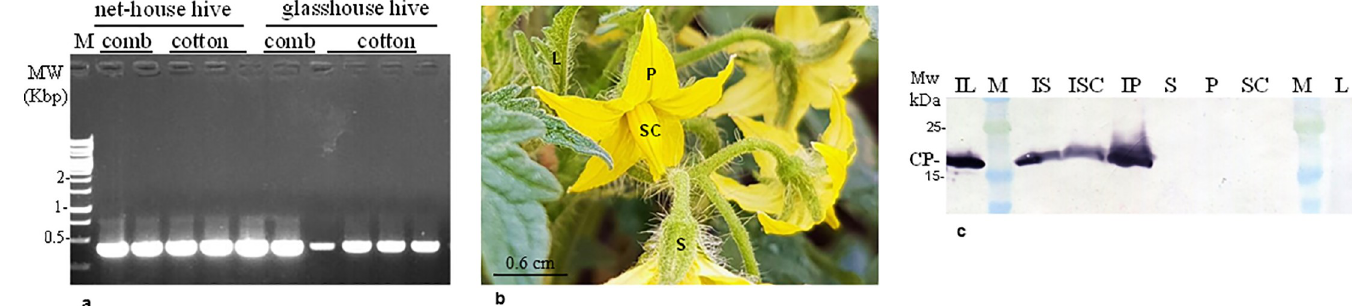
Fig 2. ToBRFV is present in hive components of beehives used in exp. # 1 and # 2 and in infected tomato flowers. a. Comb and cotton from contaminated beehives subjected to RT-PCR analysis using F-5931 and R-3’UTR primers. b. Dissected tissue parts of ToBRFV infected tomato plants. c. Western blot analysis showing coat protein of ToBRFV in dissected tomato flowers. I, ToBRFV infected plant; L, leaves; S, sepal; P, petal; SC, stamen encompassing the carpel; M, molecular size marker; CP, coat